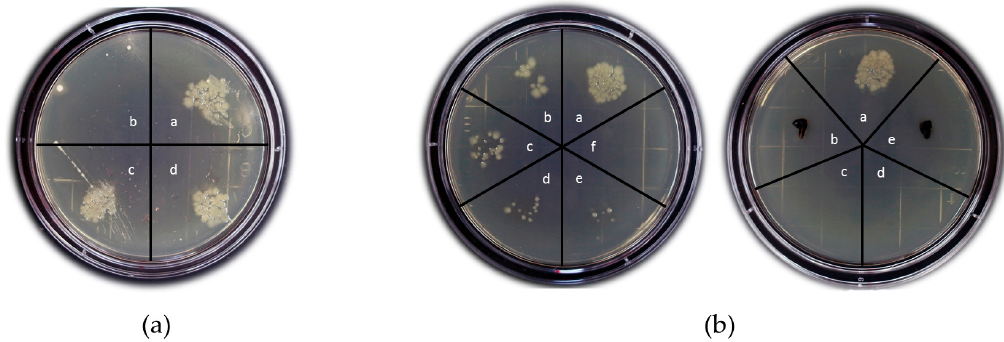
Figure 6. Reusability test results for MAC and MACAg. ( a ) Remaining microbes in treated water